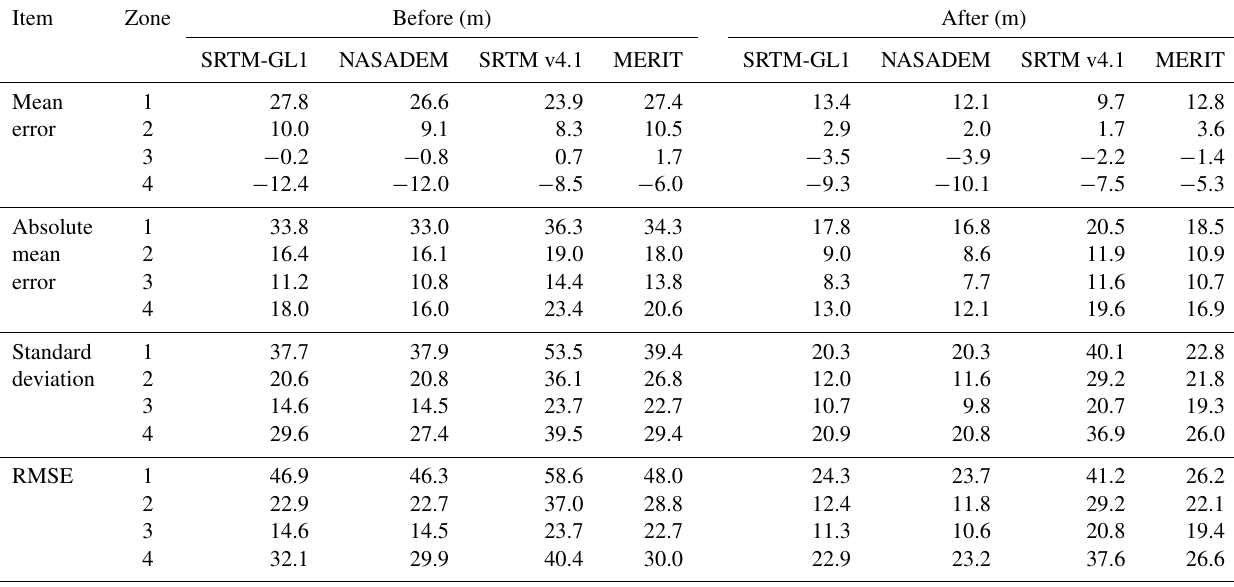
Table 3. Comparisons of differences between four SRTM-based DEMs and ICESat-2 elevation over glacier zones before and after adjustment. ICESat-2 data acquired in February are used to calculate the differences. Glacier zones are defined according to Fig. 7e.